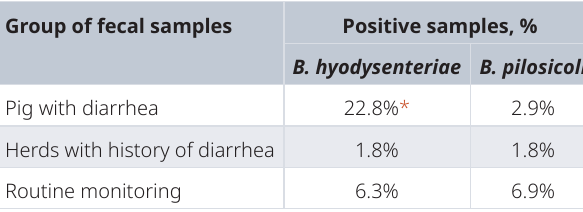
Table 1. The differences in the presence of Brachyspira hyodysenteriae and Brachyspira pilosicoli in fecal samples obtained from healthy pigs and pigs with